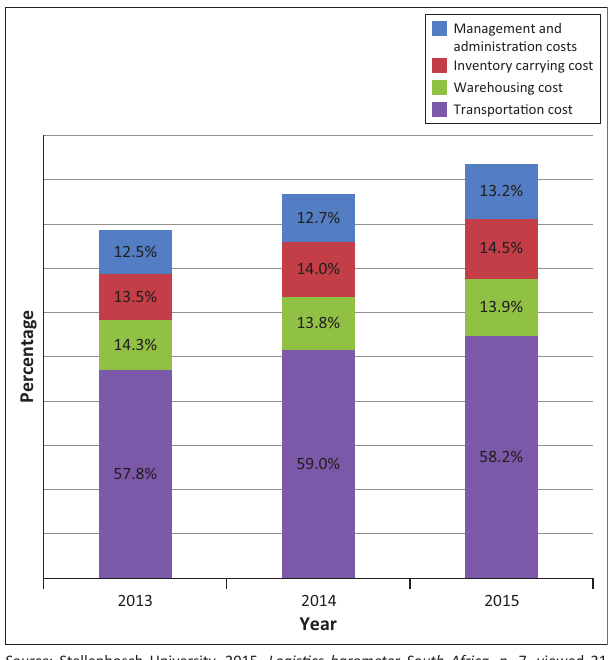
Serving Building Focussing Using Working price- long-term on demand with sensitive relationships cost- forecasts products customers with customers competition characterised mainly through mainly to by longer pooling or share life cycles sharing of knowledge resources